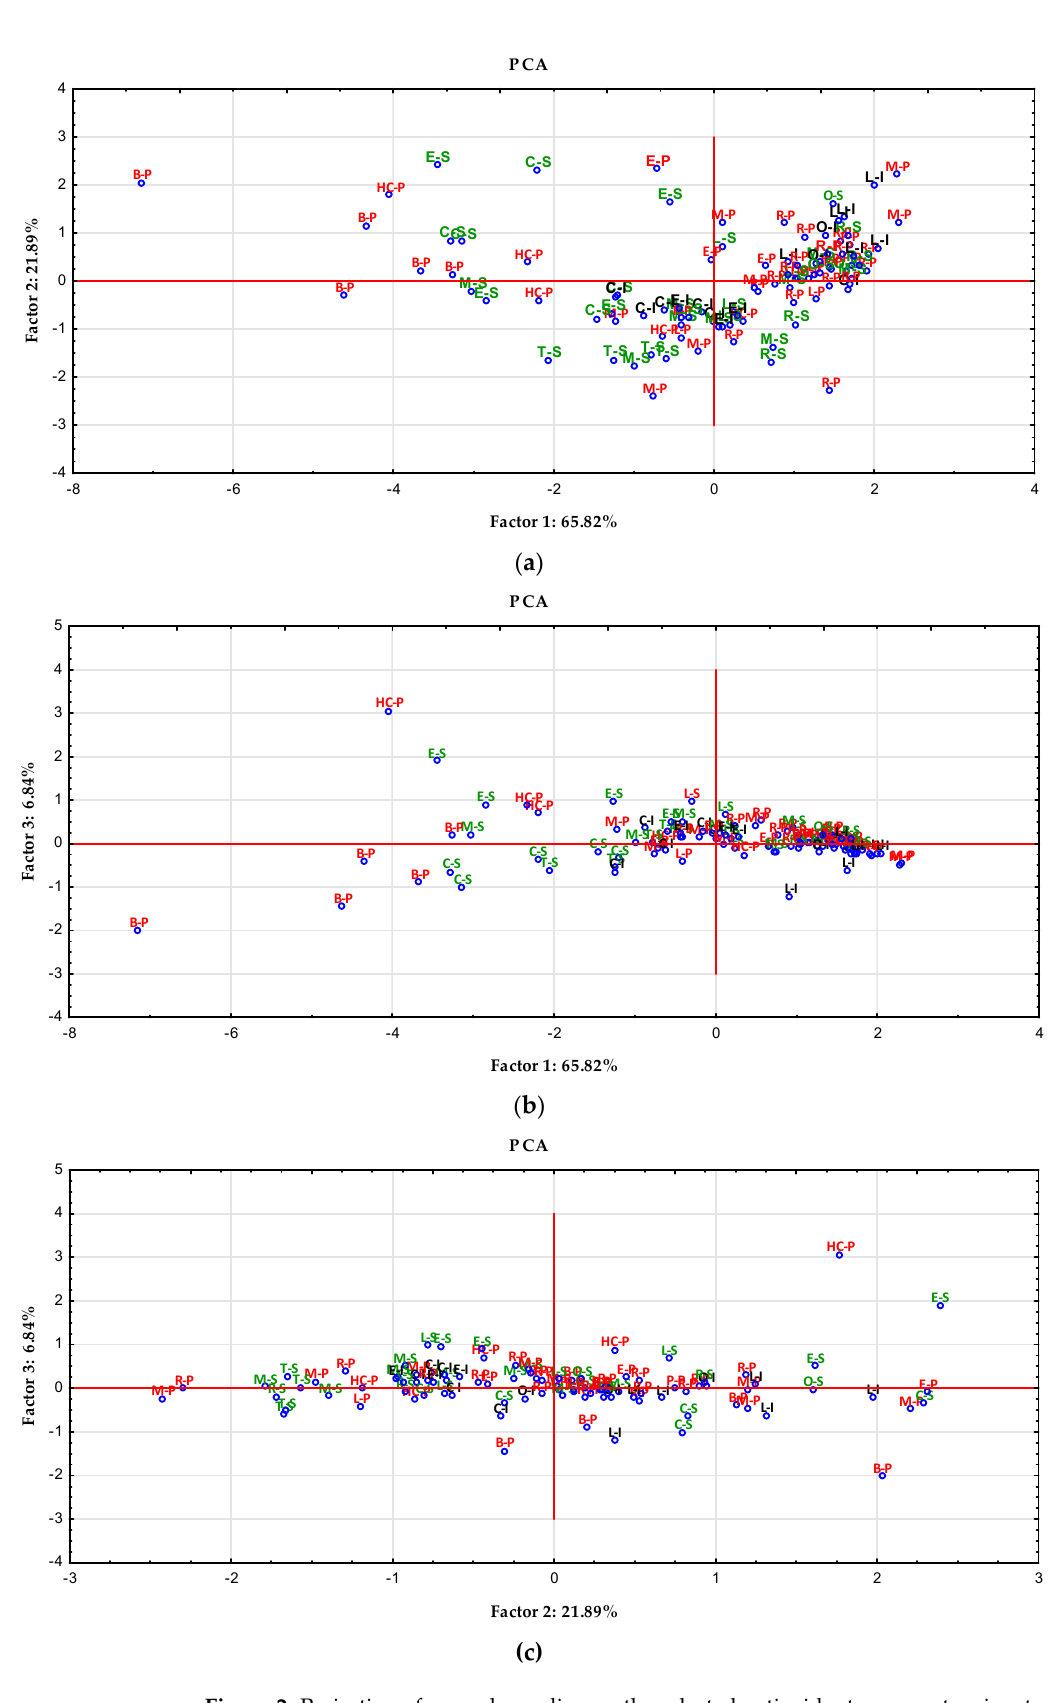
Figure 2. Projection of cases depending on the selected antioxidants parameters in a two-factor plane: factor 1 × factor 2 ( a ), factor 1 × factor 3 ( b ), factor 2 × factor 3 ( c ).